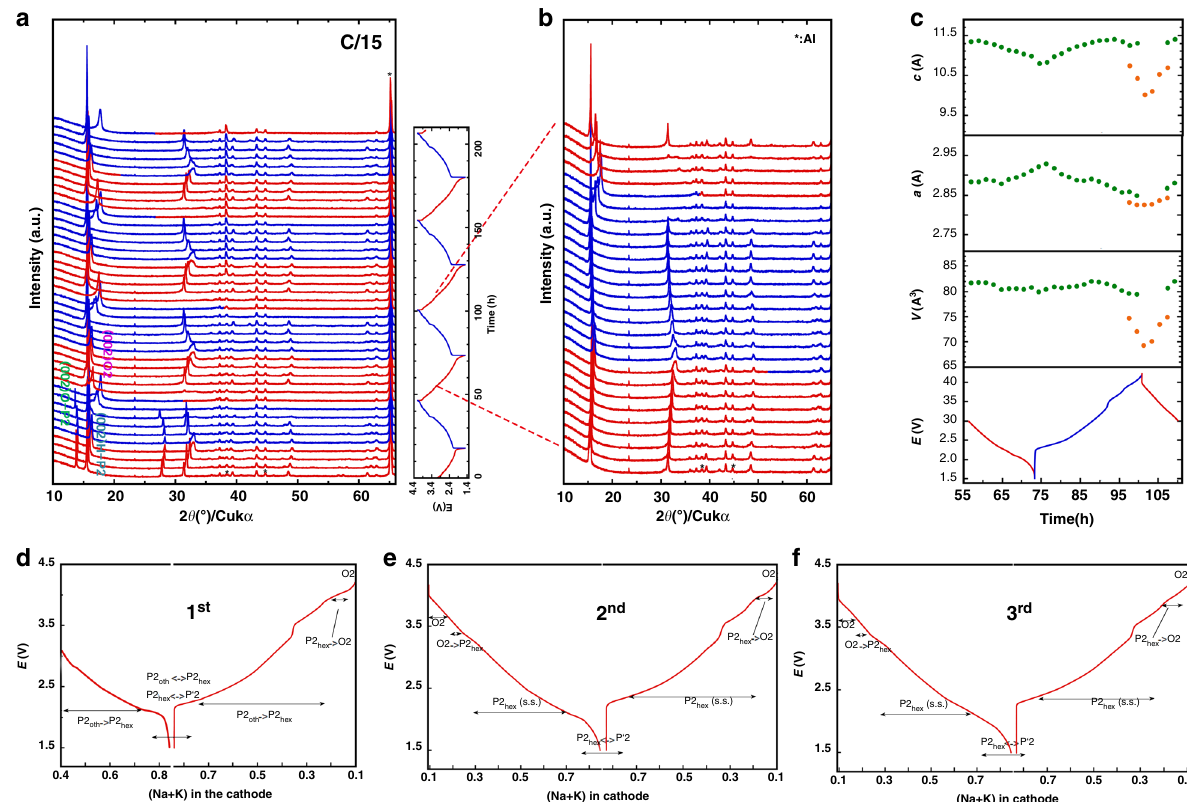
Fig. 5 In situ XRD patterns of K 0.4 Ni 0.2 Mn 0.8 O 2 electrode during electrochemical operation. a Selected XRD spectra collected during four cycles at C/15 between 1.5 and 4.2 V.; b XRD spectra focused on the 2 nd cycle; c Variation of lattice parameters during the 2 nd cycle; d – f Phase diagrams of 1 st , 2 nd , and 3 rd cycles,